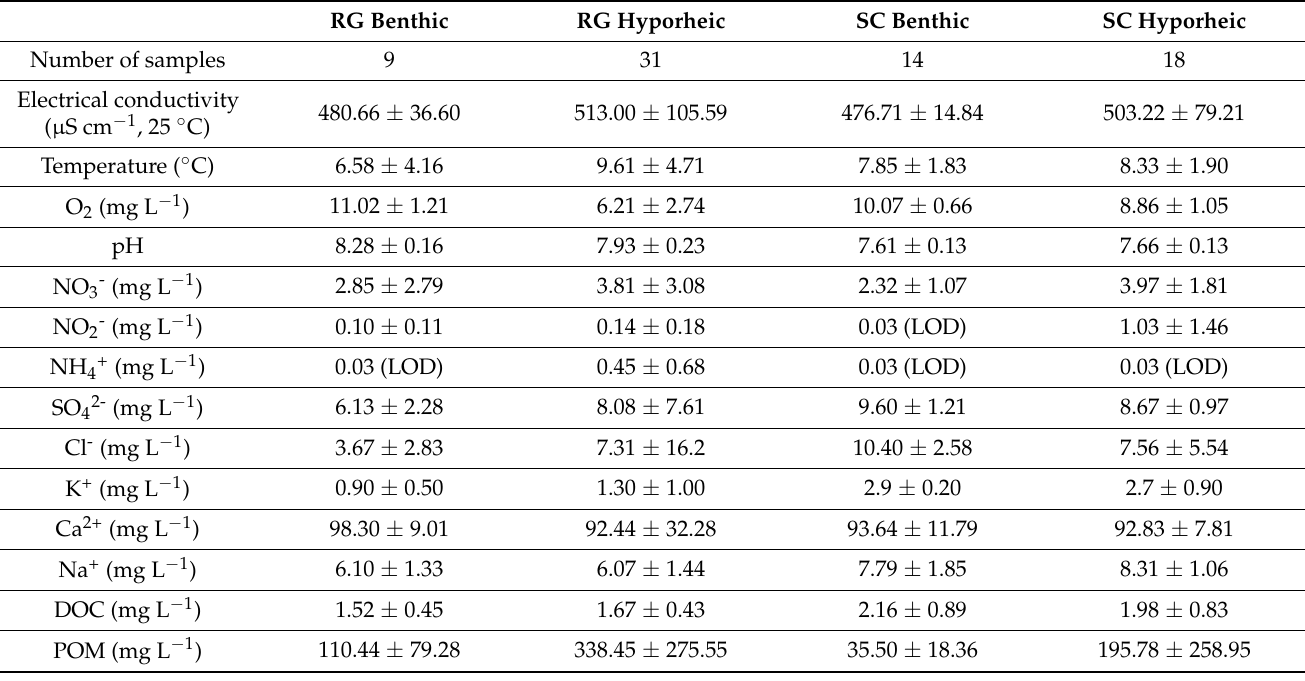
Table 1. Summary of the environmental parameters (mean ± SD) measured in the sampling sites of RG and SC (LOD = limit of detection) with SD (cid:54) = 0. RG Benthic RG Hyporheic SC Benthic SC Hyporheic Number of samples 9 31 14 18 Electrical conductivity 480.66 ±